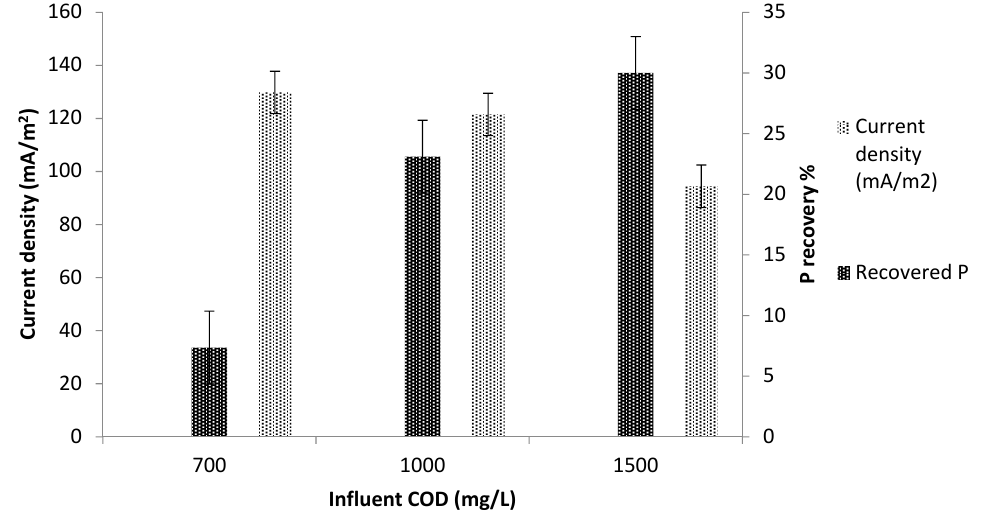
Figure 5. Impact of COD on current density and P recovery.